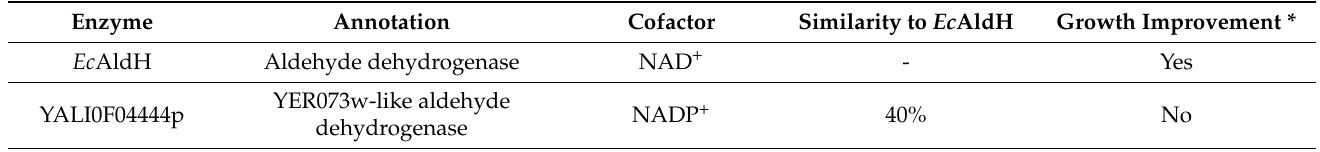
Table 1. Description of the aldehyde dehydrogenases used in this